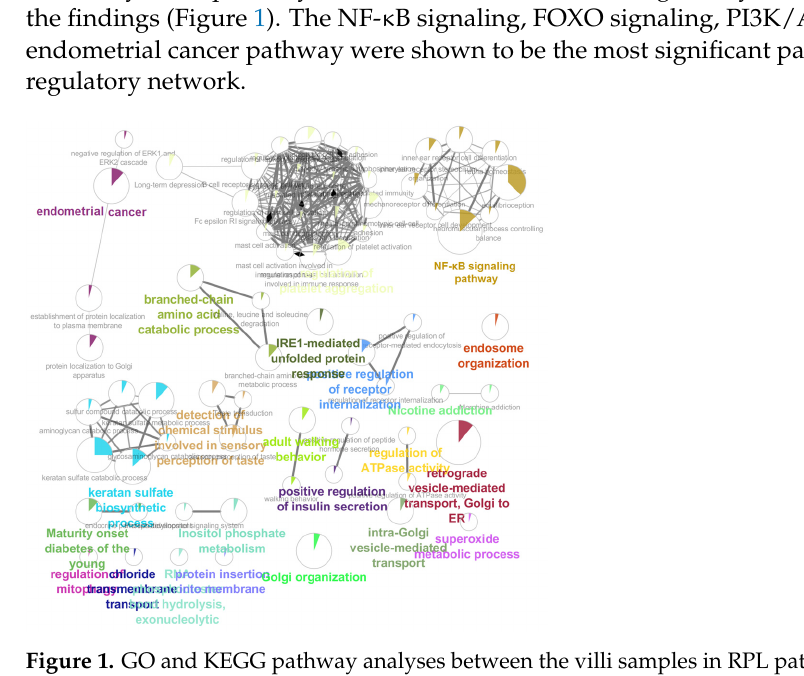
Figure 1. GO and KEGG pathway analyses between the villi samples in RPL patients and the healthy group. The size of the nodes was highly correlated with the genes’ number, and nodes gradually increased from small to large. Different colors represent various biological